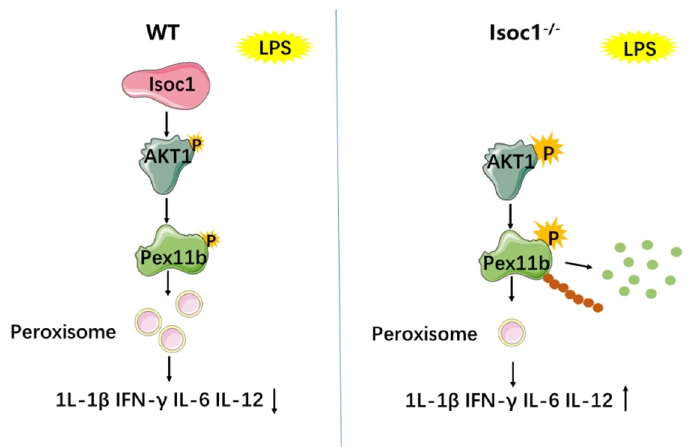
Figure 5. AKT1 phosphorylation regulates the modification and stability of PEX11B. ( A ) Wild-type RAW264.7 was pretreated with 10 μ M Perifosine for 12 h or 10 μ M SC79 for 2 h, stimulated with 300 ng/mL LPS for 24 h. qRT-PCR was used to detect the mRNA levels of PEX11B, PEX3, and PEX7. ( B ) Wild-type RAW264.7 was pretreated with 10 μ M Perifosine for 12 h or 10 μ M SC79 for 2 h, stimulated with 300 ng/mL LPS for 24 h. Western blotting was used to detect the protein levels of PEX11B, PEX3, and PEX7. ( C , D ) HA-labeled PEX11B or pCMV-HA was transfected into cells for 24 h, pretreated with 10 μ M Perifosine for 12 h or 10 μ M SC79 for 2 h, and stimulated with LPS for 24 h. The phosphorylation level ( C ) and ubiquitin level ( D ) of PEX11B were detected by Co-IP. ( E ) Cells were transfected with different ubiquitin mutants and HA-labeled PEX11B, pretreated with 10 μ M Perifosine for 12 h or 10 μ M SC79 for 2 h, and stimulated with LPS for 24 h. The interaction between PEX11B and ubiquitin was detected by Co-IP. All data are shown as mean ± s.e.m ( n = 3). * p < 0.05, ** p < 0.01, n.s. not significant. One-way ANOVA followed by Bonferroni post hoc test was used for data analysis.